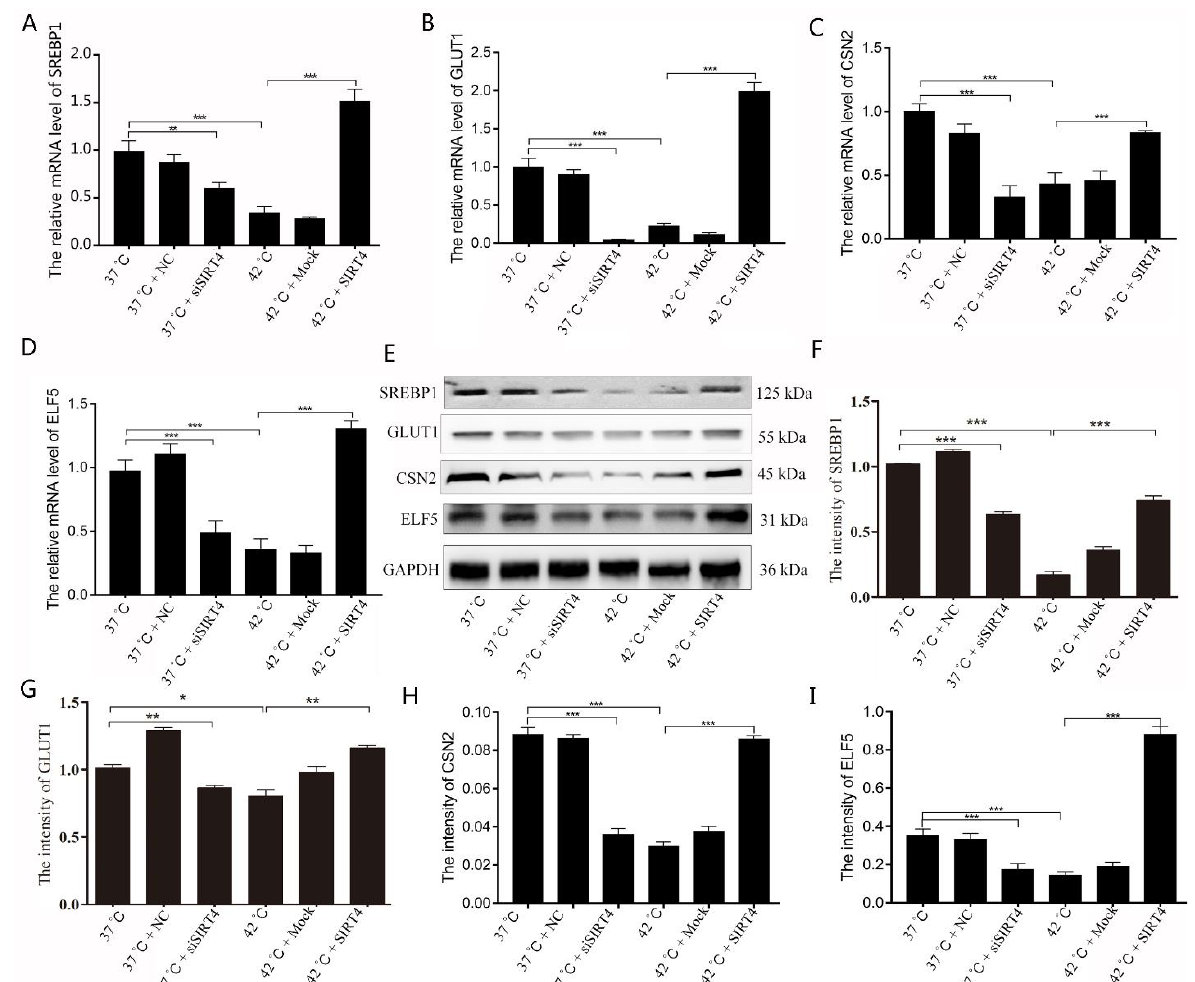
Figure 5. SIRT4 alleviated heat stress-reduced milk synthesis in BMECs. ( A – D ) The mRNA expression levels of milk proteins, as well as lipid and glucose synthesis-related genes ( SREBP1 , GLUT1 , CSN2 , and ELF5 ), in BMECs were detected by RT-qPCR after expression of SIRT4. ( E – I ) Western blotting was used to detect the protein levels of SREBP1, GLUT1, CSN2, and ELF5 in SIRT4-ex- pressed BMECs under heat stress conditions. NC: negative control; Mock: expression of control vec- tor. These results are presented as the mean ± SEM from three independent experiments. * p < 0.05,